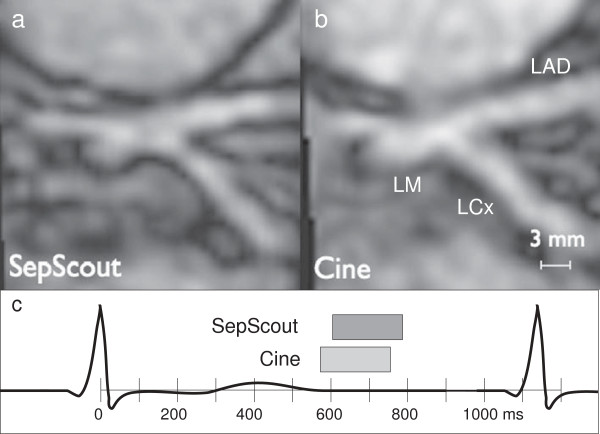
Image of a left main artery bifurcation. Image of a left main artery bifurcation acquired during (a)Wsep, and (b)Wcine. A timing diagram illustrating gating windows of the two techniques is shown in (c).